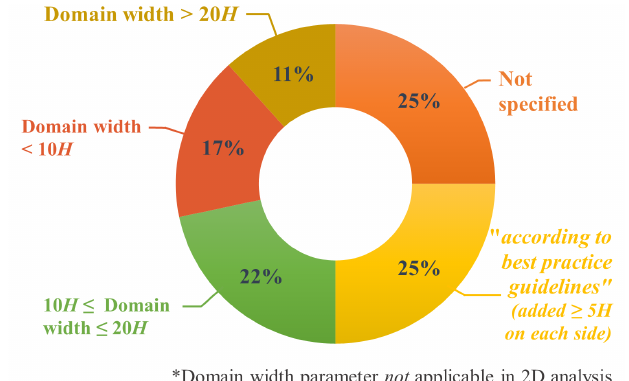
Figure 11. Domain width